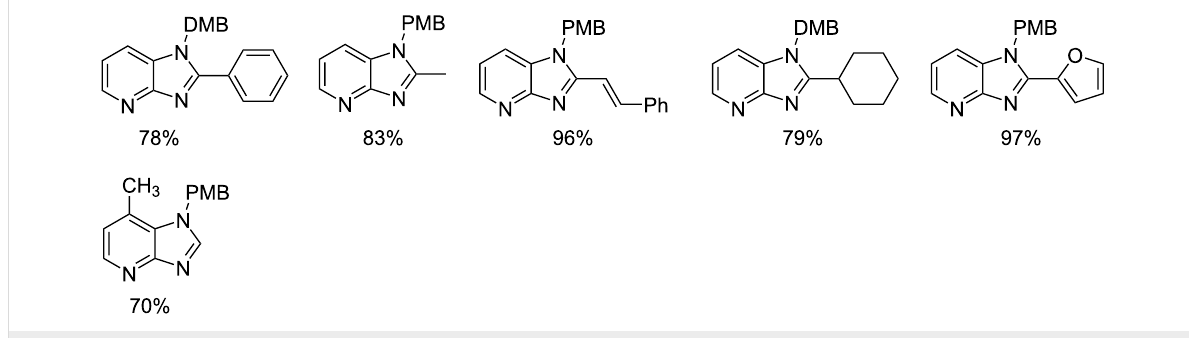
Figure 6: Amide scope.